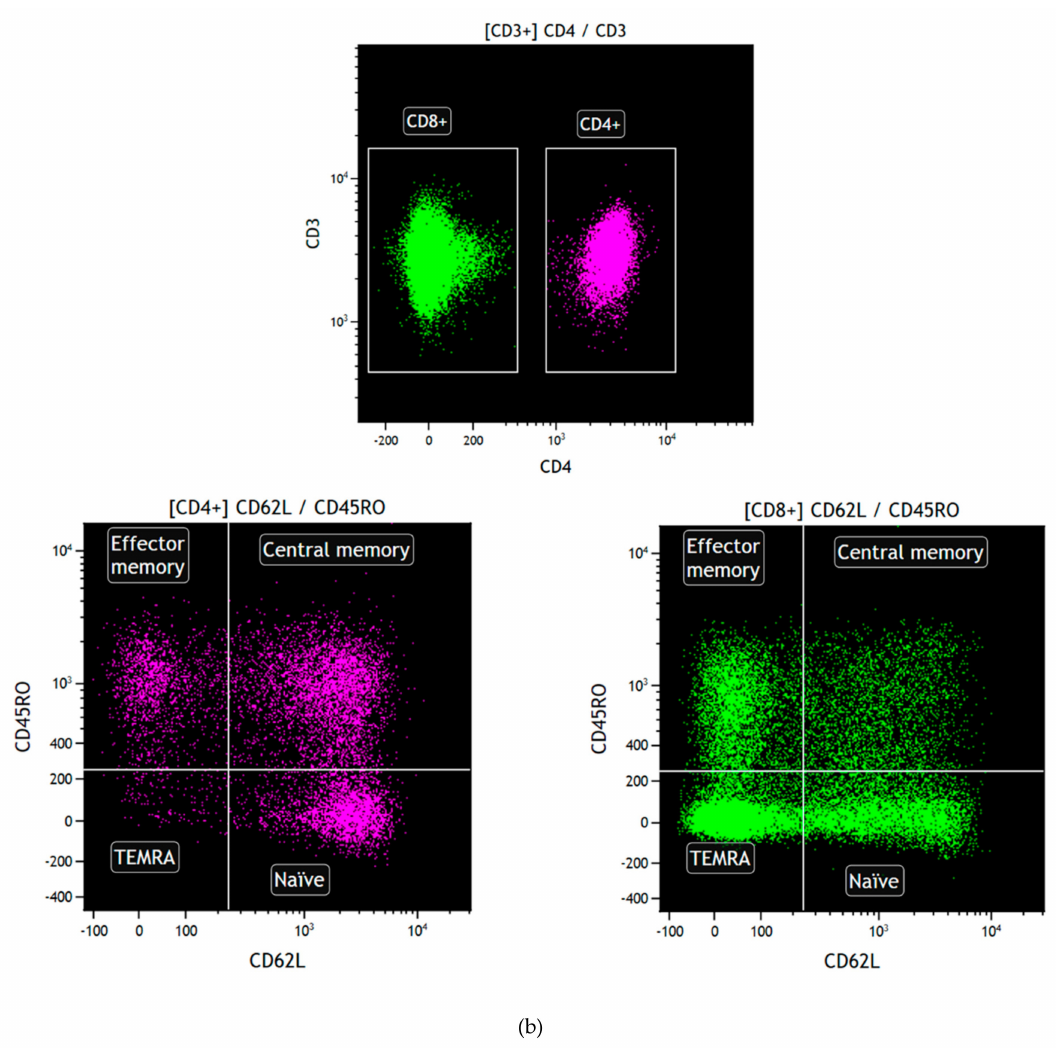
Figure 9. ( a ). Gating strategy of B cell subpopulations. Lymphocytes were identified by FSC